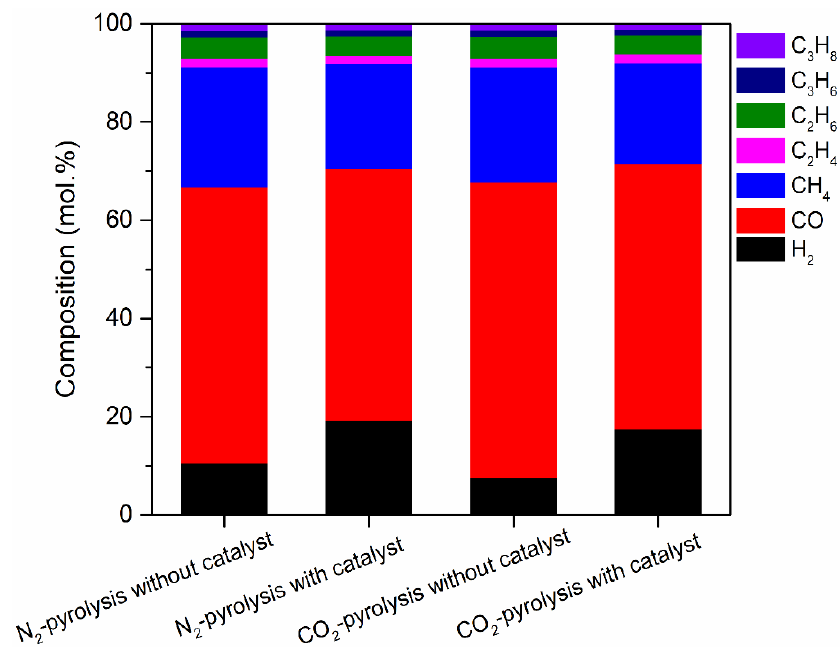
Figure 4. Composition of pyrolytic gas evolved from the pyrolysis of the herbal medicine waste in four different conditions. Note that CO 2 is intentionally excluded in this figure, because the condensed CO 2 concentration was measured for the catalytic and non-catalytic CO 2 pyrolysis experiments in our micro GC. The composition data including CO 2 for the catalytic and non-catalytic N 2 pyrolysis experiments are given in Figure S3 in the Supporting information. Mean values of replicates (n = 3) are reported and standard deviations of the mean values are around 5%.